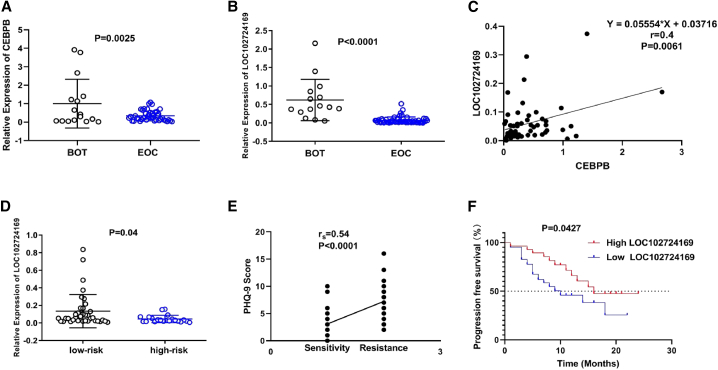
Chronic stress promoted tumor progression in EOC patients(A) Clinical sample validation of CEBPB expression in BOT and EOC. (B) Clinical sample validation of LOC102724169 expression in BOT and EOC. (C) Correlation analysis of CEBPB and LOC102724169 expression levels by a Pearson correlation coefficient (r = 0.4, p = 0.0061). (D) Validation of LOC102724169 expression between high-risk stress group and low-risk stress group. LOC102724169 showed low expression in the high-risk group. (E) Spearman rank regression was used to analyze the correlation between chronic stress and cisplatin resistance. (F) Kaplan-Meier analysis and a log-rank test were used to show progression-free survival curves of EOC patients with different expressions of LOC102724169. Data are represented as mean ± SEM. BOT, benign ovarian tumor; EOC, epithelial ovarian cancer.